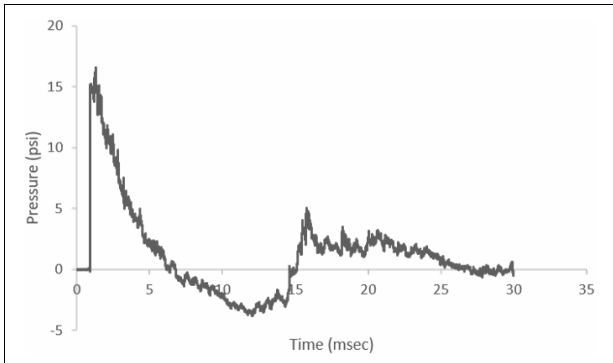
FIGURE 2 | Representative Friedlander-like ABS waveform. The ABS device produced a waveform with an average of 15.56 psi peak incident pressure and 469.74 m/s shock wave velocity. The shock wave positive phase duration was 5.62 ms and negative phase duration was 8.40 ms.